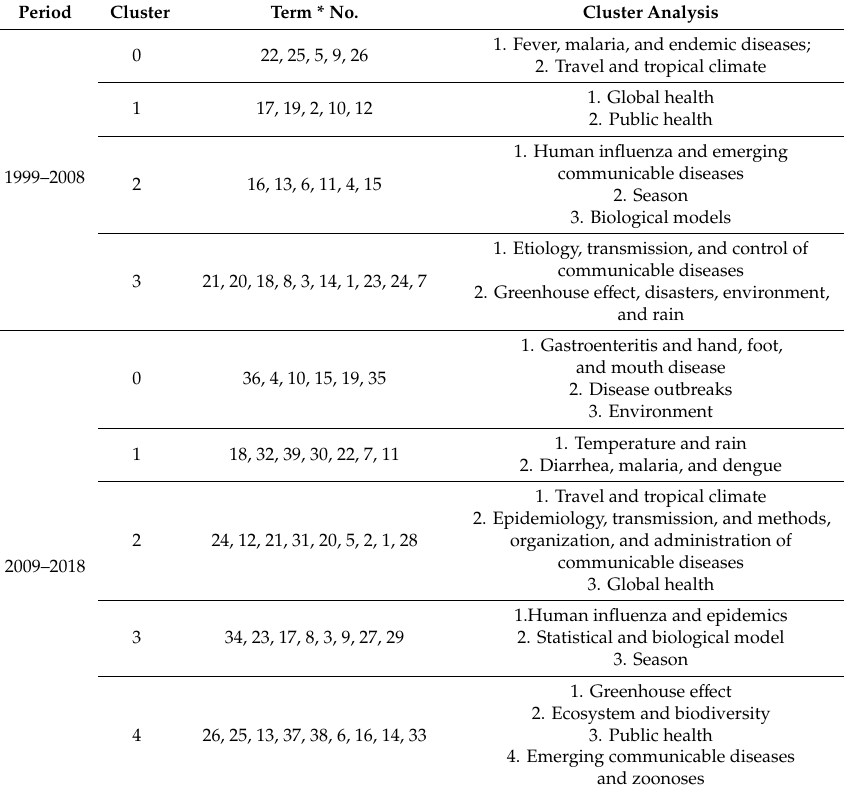
Figure 3. Mountain and matrix visualization of biclustering of highly-frequent major medical subject headings (MeSH)/subheading combination terms and articles on climate change and infectious diseases from 1999 to 2008. Table 2. Hotspots of climate change and infectious diseases explored by biclustering analysis of high-frequency major MeSH / subheading combination terms in 1999–2008 and